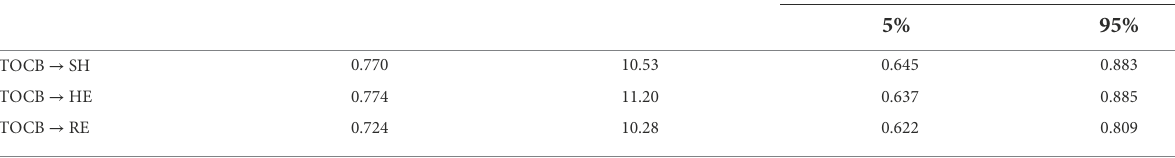
TABLE 2 Results of second order